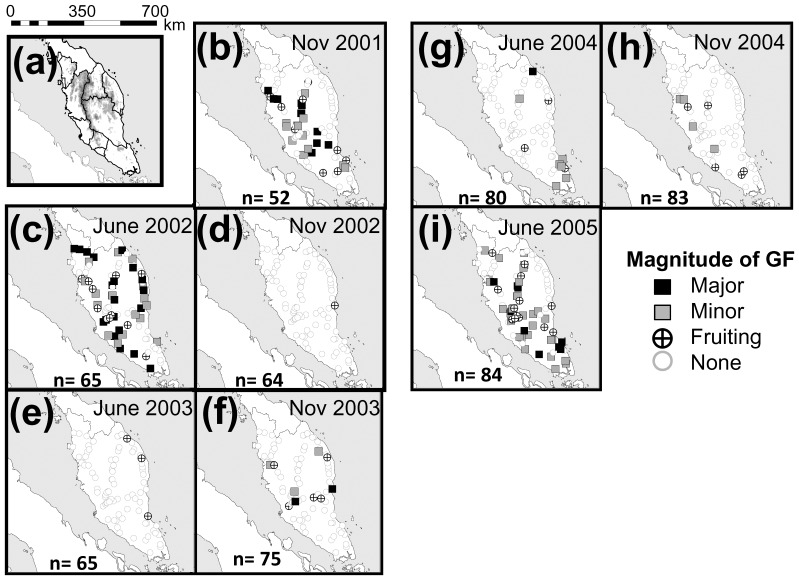
Geographical distribution of GF from November 2001 to June 2005.Each site was scored for the density of fruiting dipterocarp trees (major GF, minor GF, sporadic fruiting or none). (a) Topography of Peninsular Malaysia. (b, d, f, h) GF scores in November–December 2001–2005 (the autumn type). (c, e, g, i) GF scores in June-July 2002–2005 (the spring type).